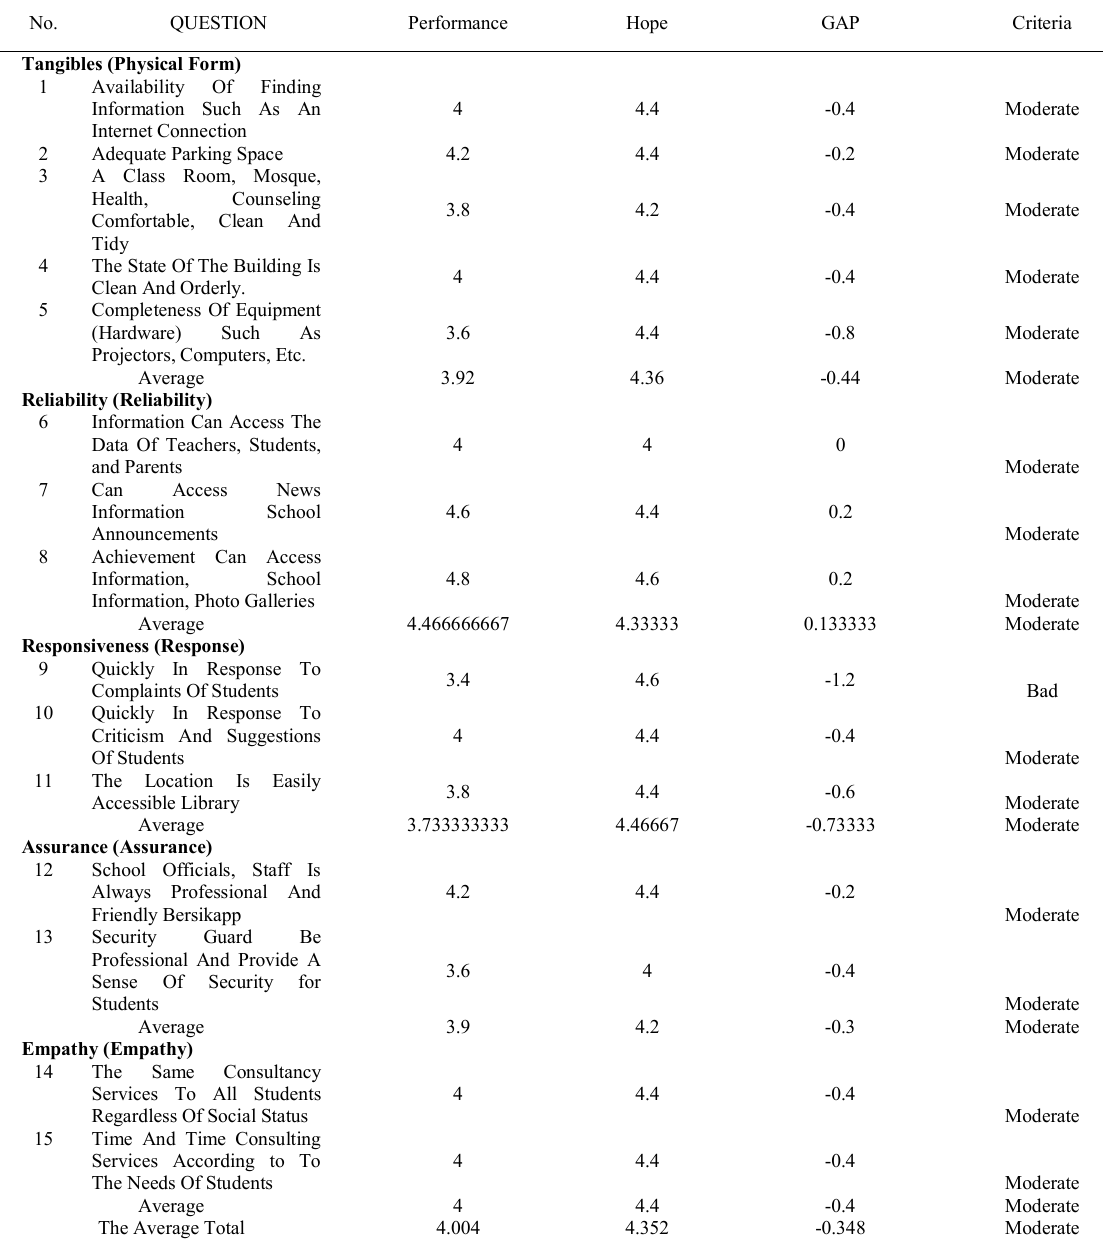
TABLE 4. VALUE SERVICE QUALITY